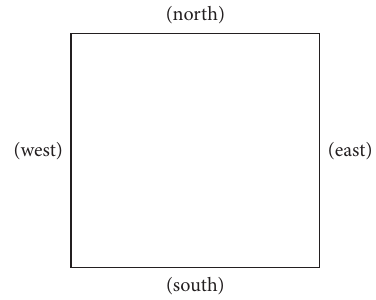
Figure 2: Location diagram.